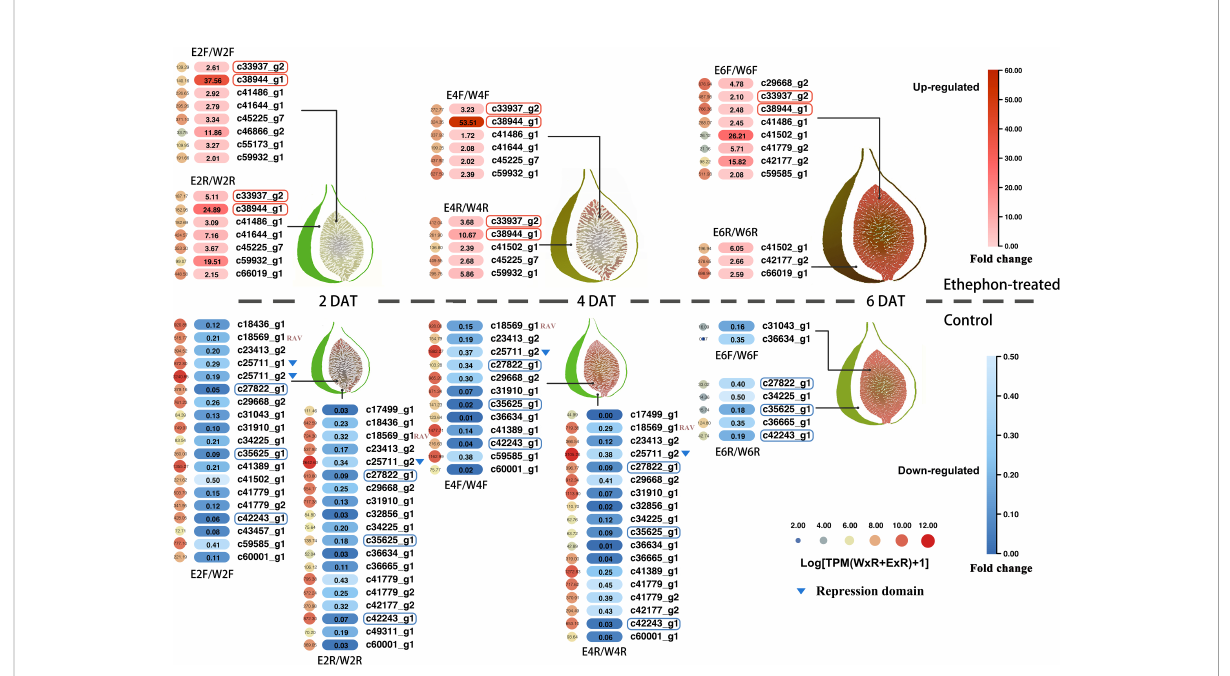
FIGURE 7 Changes in FcAP2/ERF gene expression in fi g fruit fl esh and receptacle tissues after ethephon treatment. Color intensity indicates the ratio of expression in ethephon-treated tissues compared to control tissues. Genes circled in red or blue were differentially expressed in all fi ve comparisons of treated to control